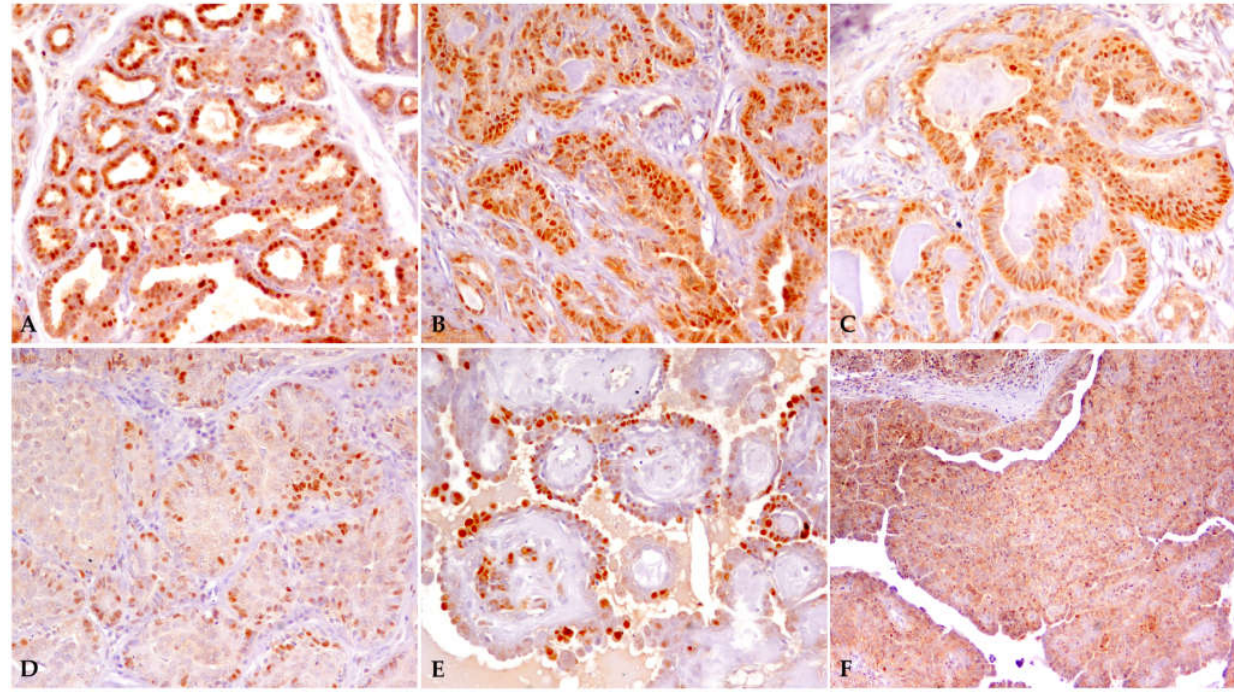
Figure 1. ERα immunoexpression in canine mammary samples. ( A ) Normal mammary gland, TS = 8; ( B , C ) tubulopapillary adenoma, TS = 8; ( D ) solid carcinoma, grade III, TS = 3; ( E ) intraductal papillary adenoma, TS = 4; ( F ) solid carcinoma, grade II, TS = 4. Ki67 positivity was evaluated in all mammary samples. Ki67 positivity across all CMTs was 40.09 ± 22.97% (mean ± SD). Ki67 positivity was 21.97 ± 10.21% and 47.34 ± 22.79% in benign and malignant canine mammary tumors, respectively. No significant differences ( p > 0.05) were found in the mean Ki67 index between benign tumors (Group B: coefficient of variation, 76.57%; median, 19.60; minimum, 12.00; maximum, 77.20) and malignant CMTs (Group M1–3: coefficient of variation, 48.15%; median, 54.00; minimum, 7.00; maximum, 87.60).